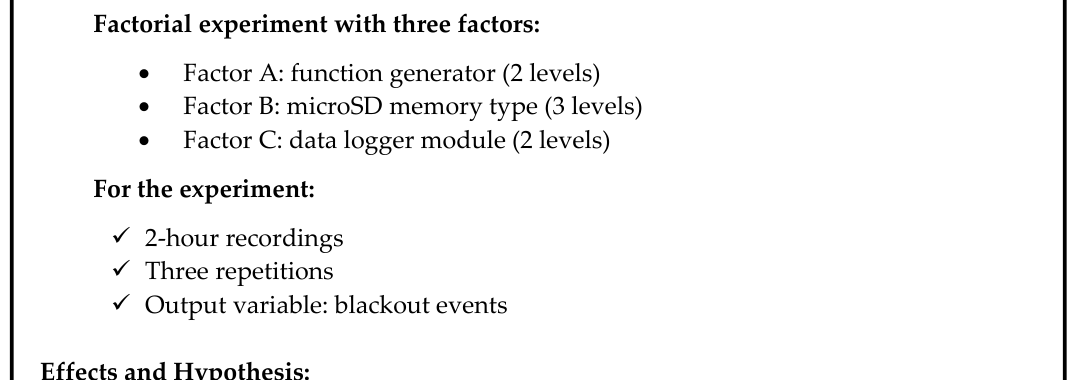
Figure 11. Structure, hypothesis, and effects of experimental design.